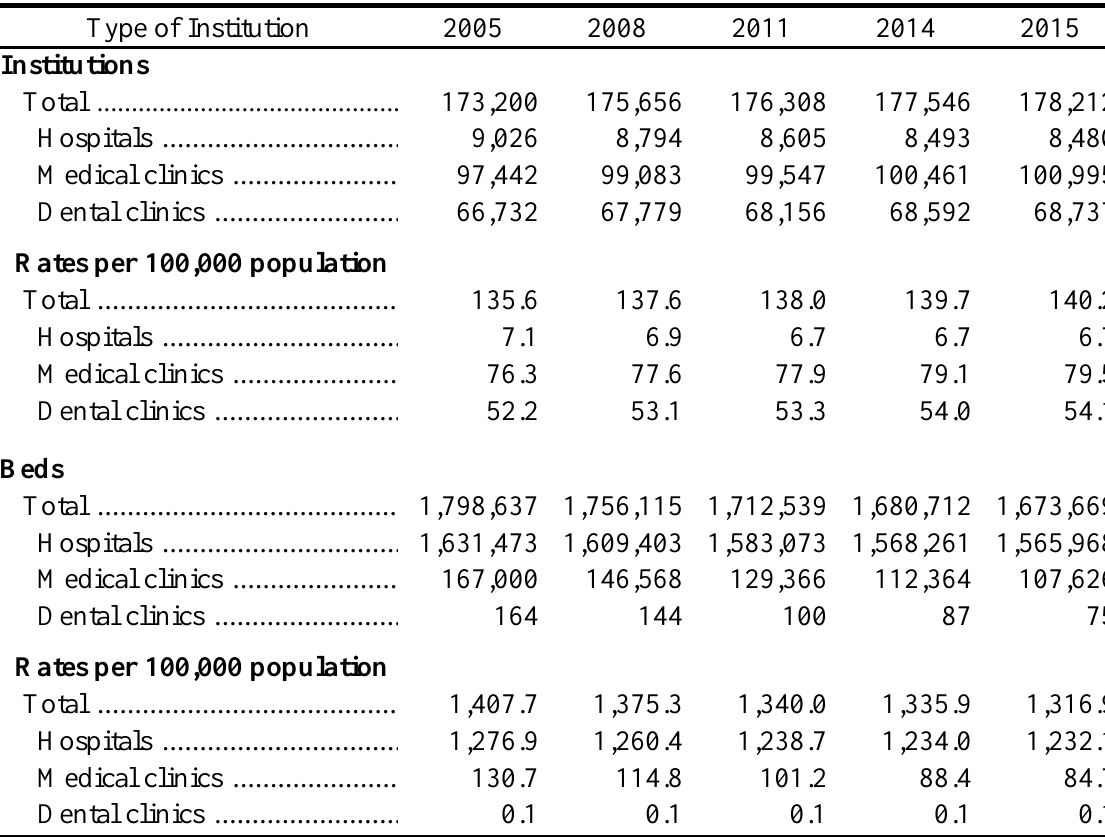
Rates per 100,000 population